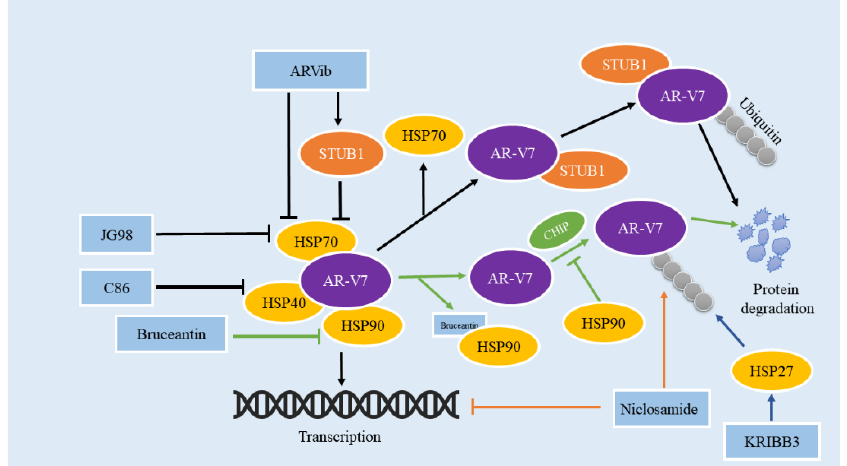
Figure 3. Natural/compound drugs affect the transcriptional activity and protein stability of AR-V7 through the HSP family. ARVib, JG98, and C86 promote AR-V7 degradation by inhibiting HSP40/HSP70 axis; bruceantin promotes AR-V7 degradation by directly binding to HSP90 and disrupting the interaction between HSP90 and AR-V7; KRIBB3 promotes the degradation of AR by interacting with HSP27; niclosamide not only inhibits the transcriptional activity of AR-V7 but also promotes the degradation of AR-V7.